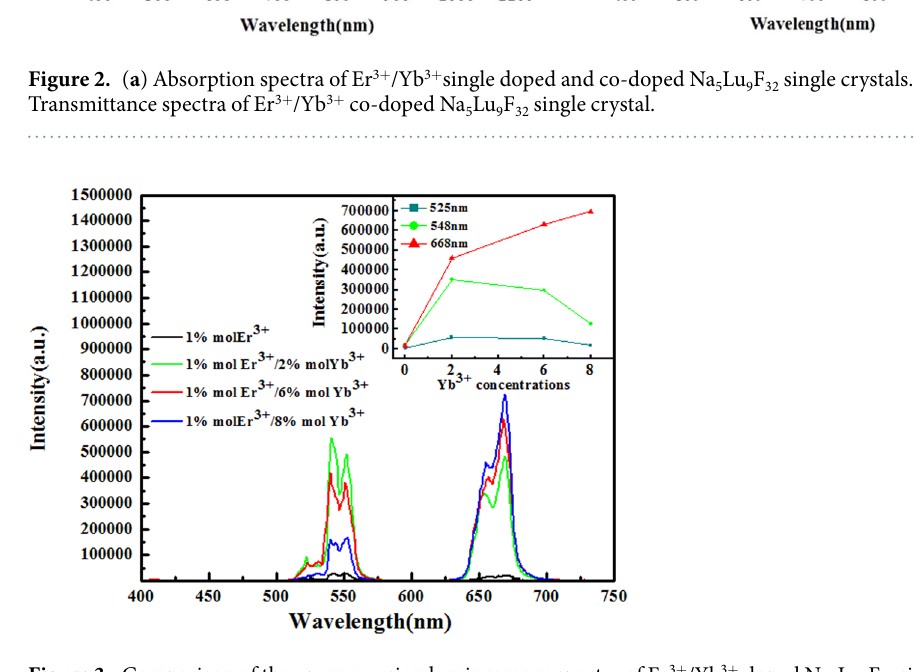
Figure 3. Comparison of the up-conversion luminescence spectra of Er 3 + /Yb 3 + doped Na 5 Lu 9 F 32 single crystals under 980 nm excitation at room temperature; the inset shows the integrated total intensity on Yb 3 + concentrations in Er 3 + /Yb 3 + doped Na 5 Lu 9 F 32 single